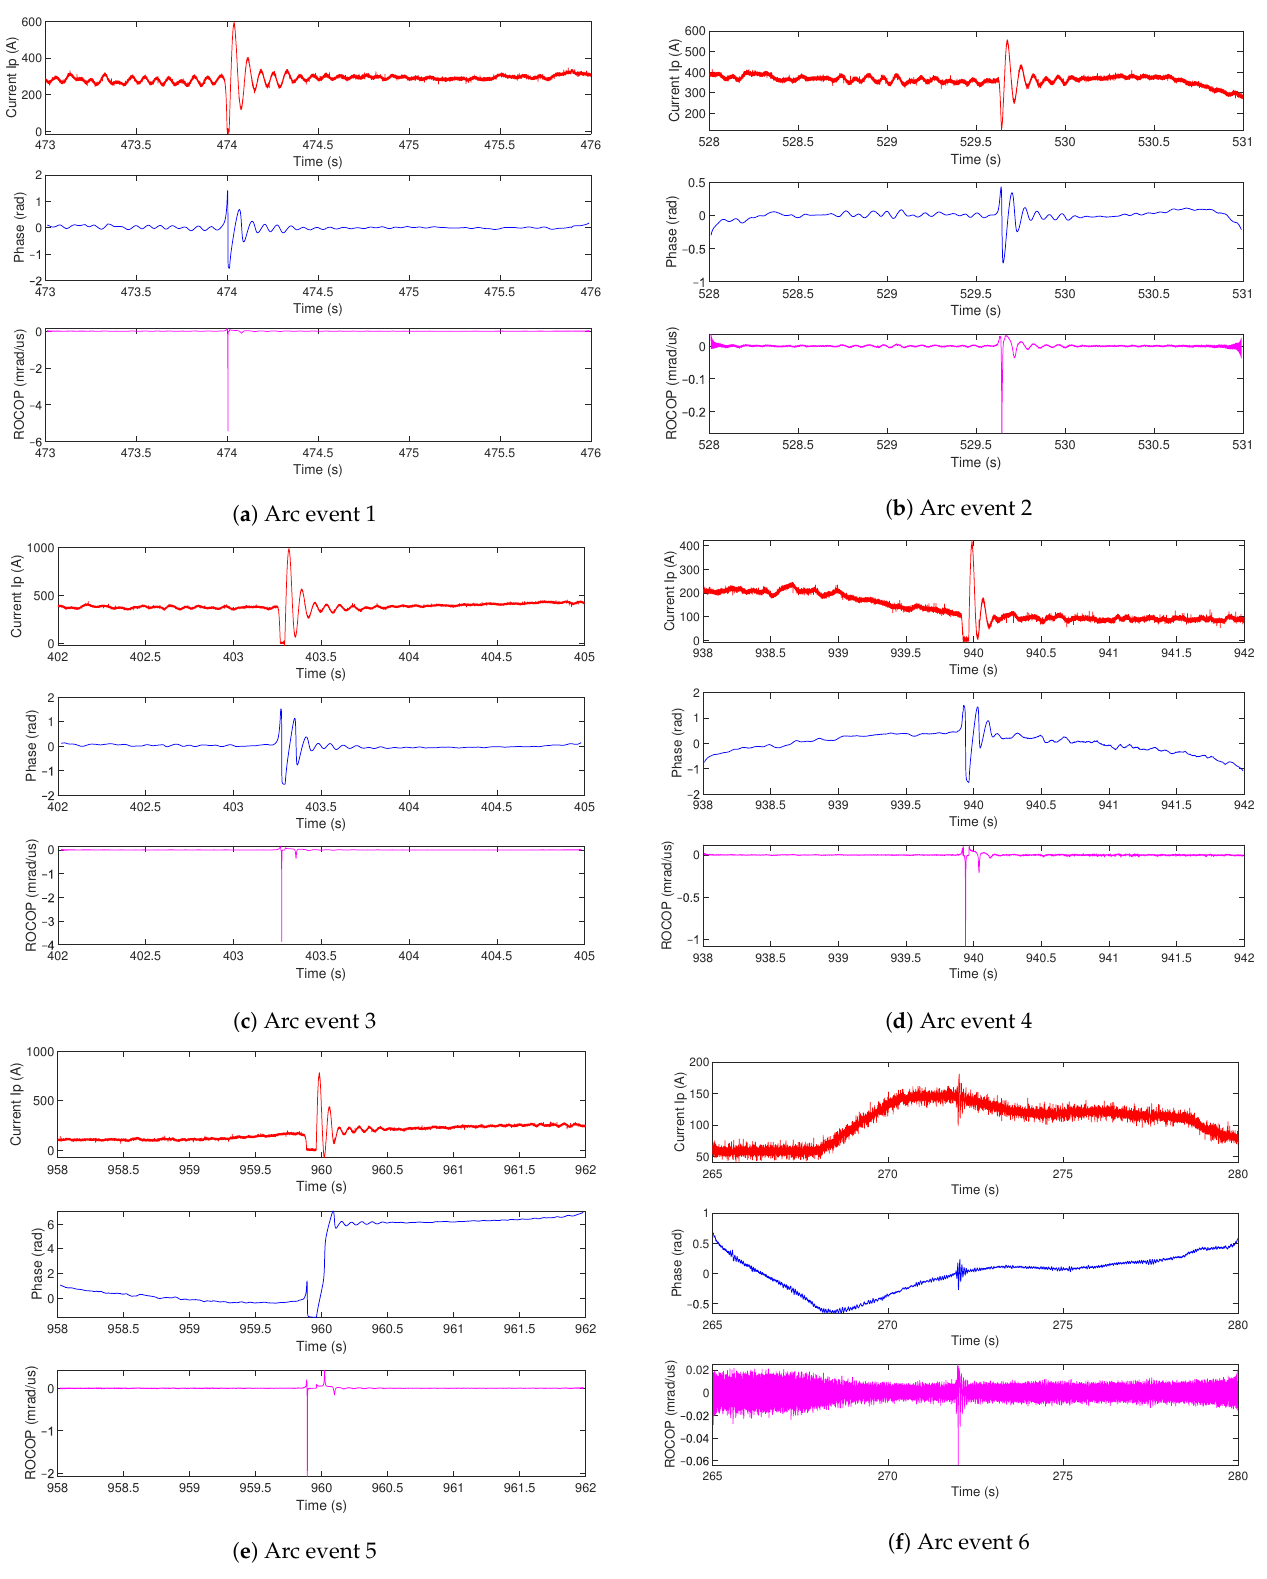
Figure 4. Instantaneous recorded I p , instantaneous calculated phase angle, and instantaneous ROCOP for all of the